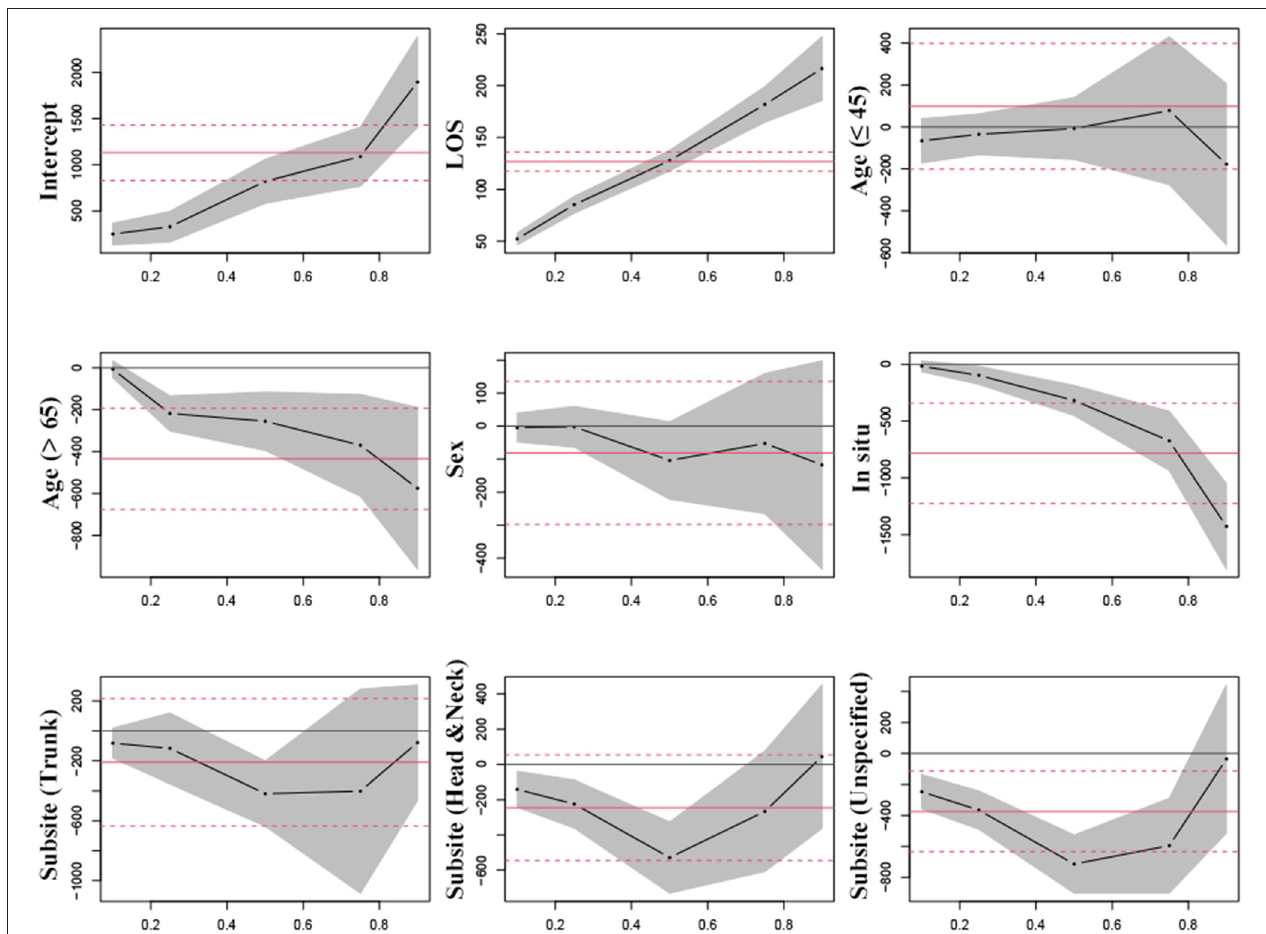
FIGURE 3 | Estimated parameters for hospitalization costs in patients with melanoma undergoing surgery by quantile regression versus linear regression. Black lines signify the point estimates by quantile regression at 0.1, 0.25, 0.5, 0.75, and 0.9 quantiles (gray bands signify 95% confidence intervals); and red lines signify the point estimates by linear regression (red dash lines signify 95% confidence